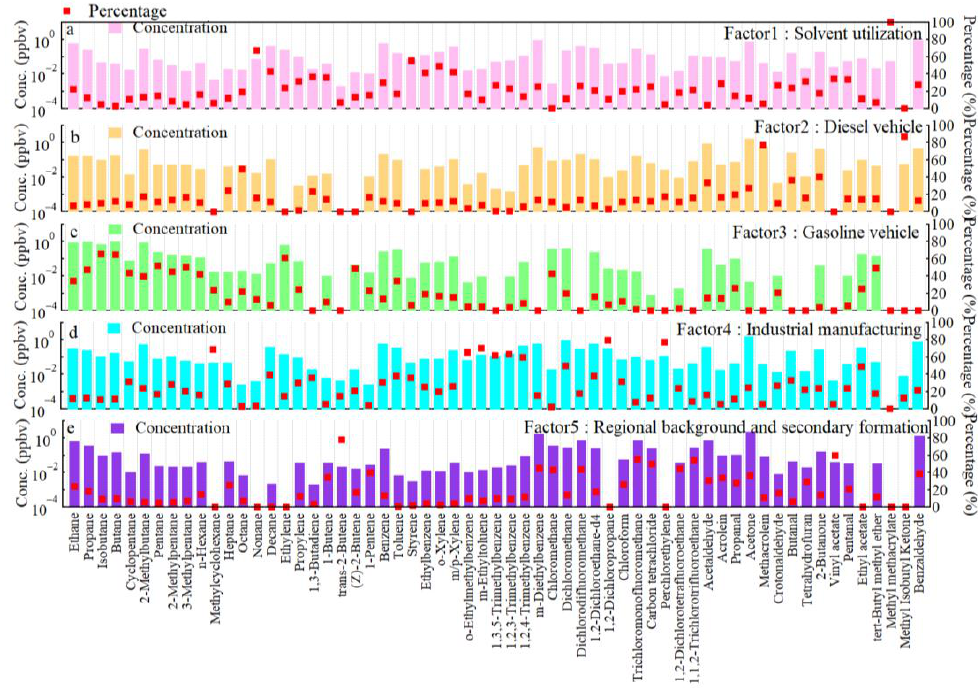
Figure 7. Source profiles of VOCs resolved from PMF in summer.